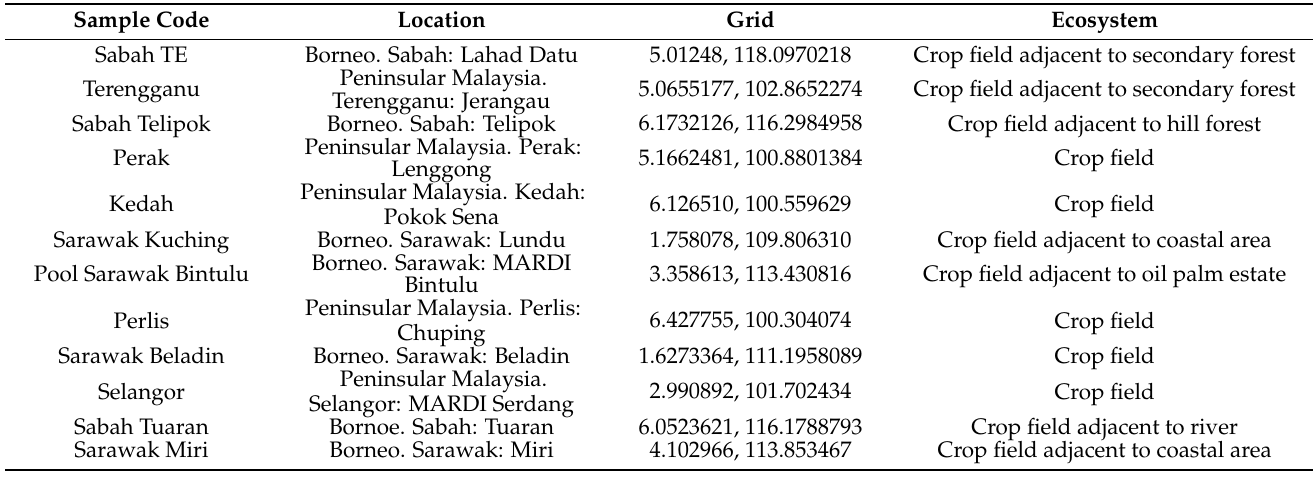
Table 1. List of samples used for metabarcoding analysis.